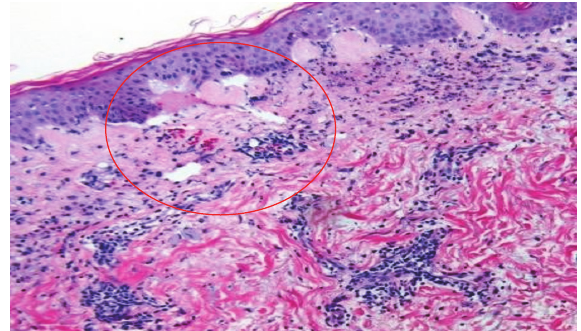
Figure 5: H&E, upper chest punch biopsy. Focal subepidermal blistering with dermal PMN infiltrate.